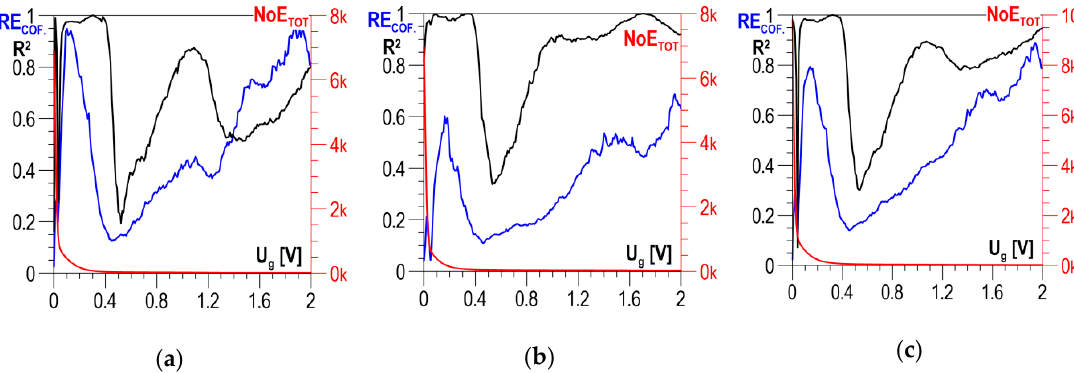
Figure 18. NoE TOT distributions and distributions of coefficients RE COF and R 2 as a function of threshold voltage U g —Configuration C3 ( a ) parallel direction; ( b ) normal direction; ( c ) absolute value. The RE COF distributions for this voltage range have a local maximum that decides the selection of discrimination voltage U g (from 0.1 to 0.16 V) for which the correlations presented in Figure 19a–c were developed. The values of determination coefficient R 2 are included in the range from about 0.97